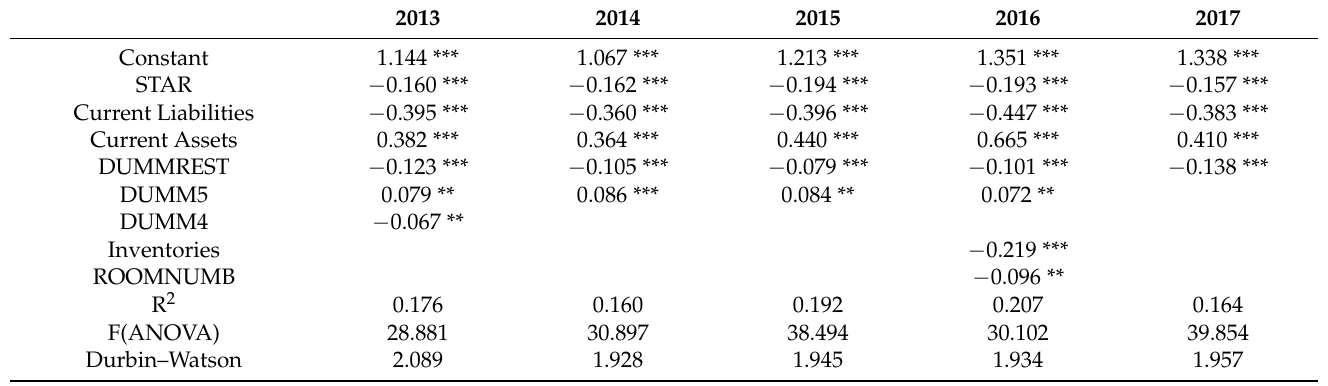
Table 12. Log-linear regression of Current Ratio.